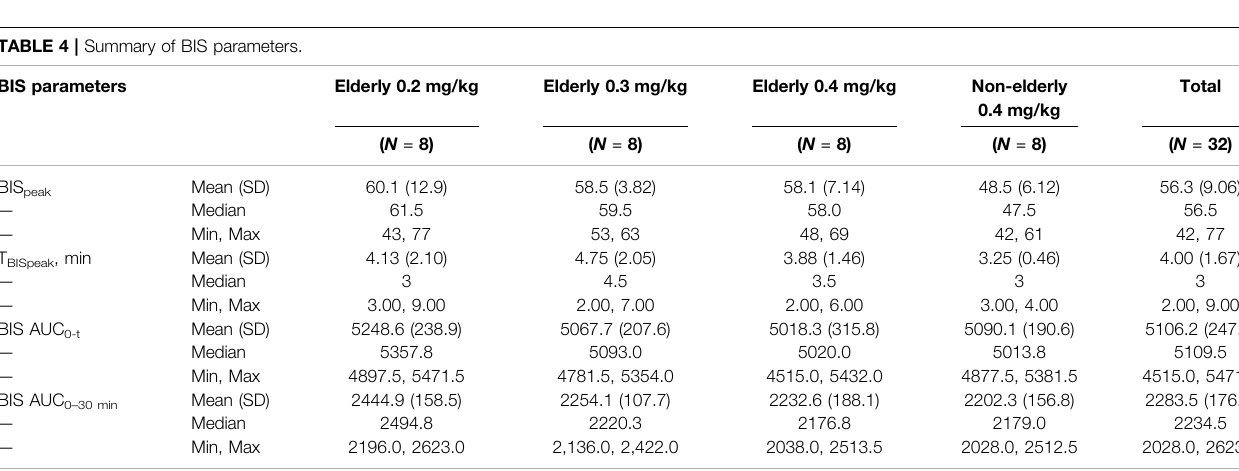
TABLE 4 | Summary of BIS